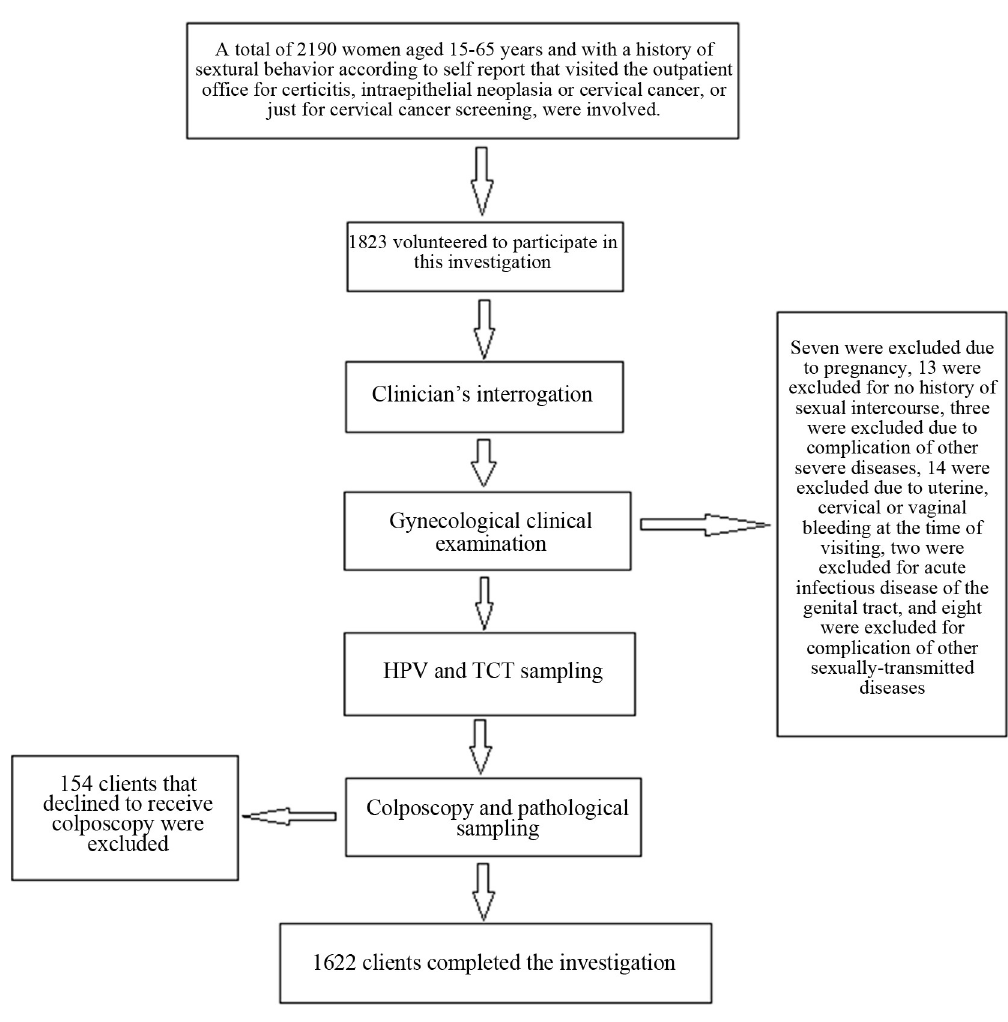
Fig 1. Flow chart of the recruitment for this